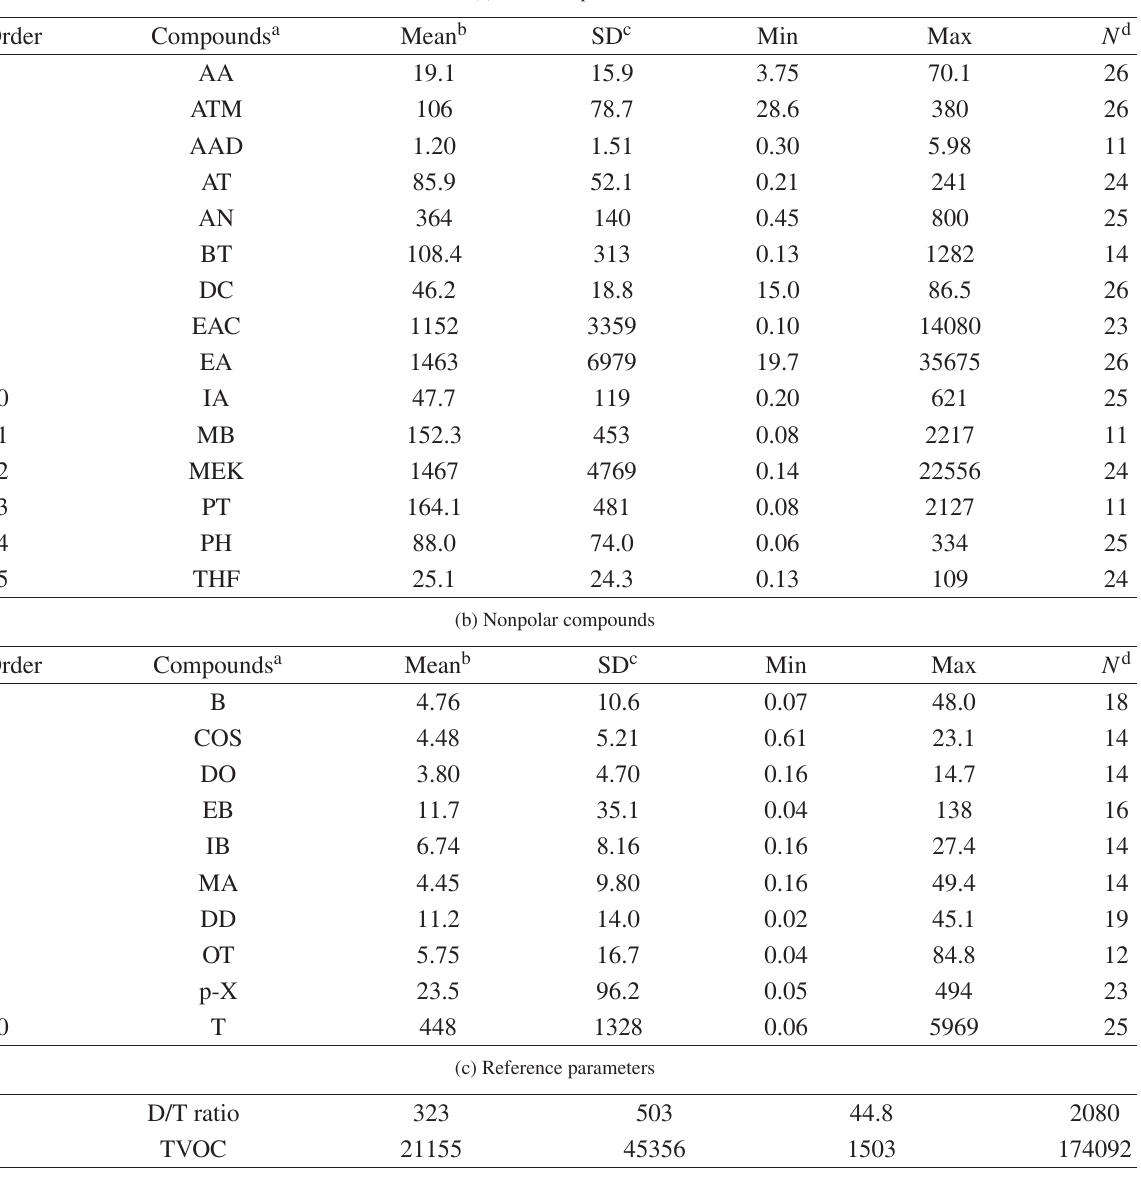
TABLE 3: Statistical summary of volatile organic compounds found in used Tedlar bags (ppb